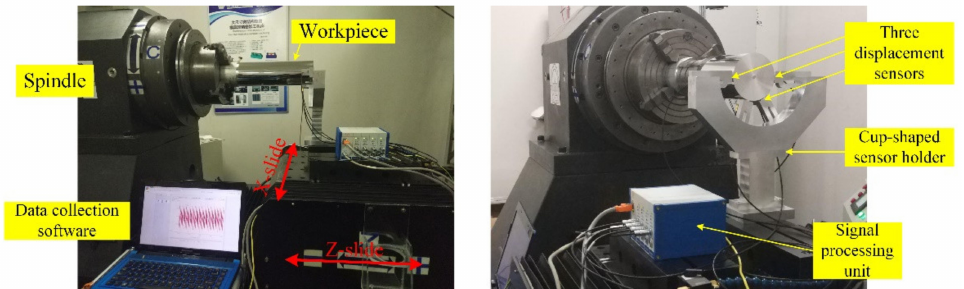
Figure 3. Photographs of the diamond turning machine and measuring devices: ( left ) front view, ( right ) side